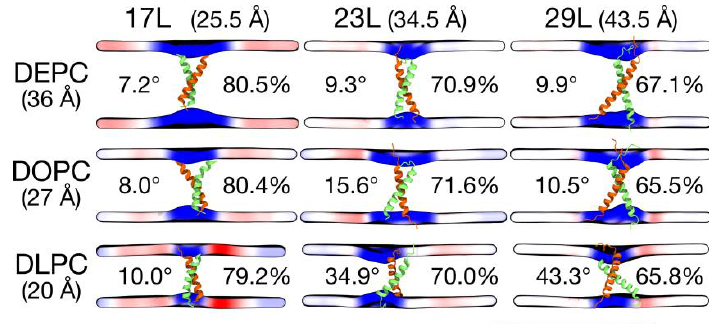
FIGURE 4: Summary of the results from MD simulations of homo-dimers. The peptide and the membrane are un- changed along the columns and rows, respectively. The hydrophobic length of the peptide and the hydrophobic thickness of the membrane are given in brackets. The two peptides are shown in green and orange, while the mean positions of the phosphorus atoms in lipid head-groups are shown as a surface. This surface is colored according to the value of local average membrane (phosphorus– phosphorus) thickness with respect to (w.r.t.) the bulk membrane thickness far away from the dimer. The thick- nesses are calculated from the last 500 ns of the simula- tions. The average tilt of the peptides is given in degrees and the average alpha-helical content in